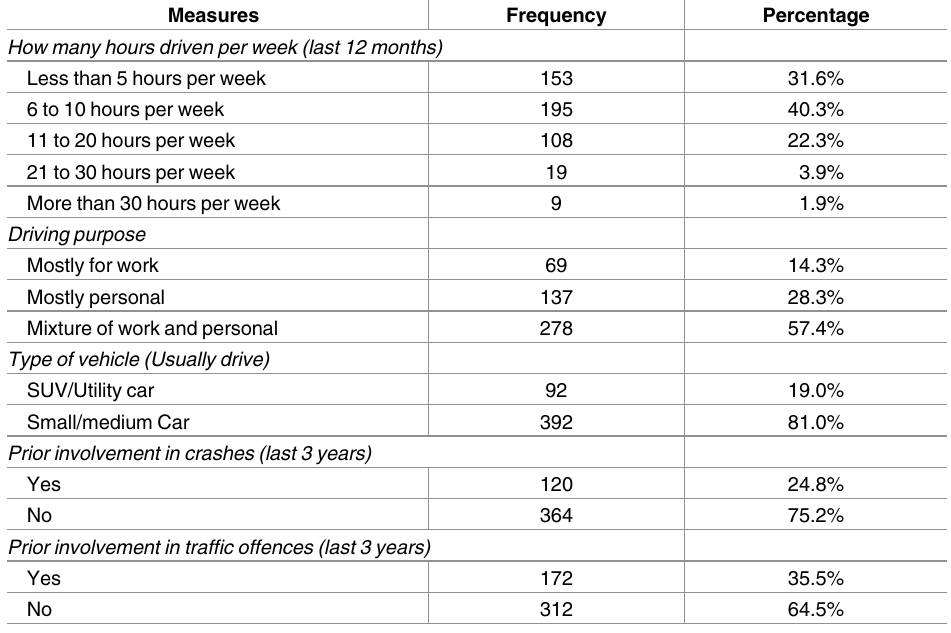
Table 1. Respondents’ demographic profile and driving